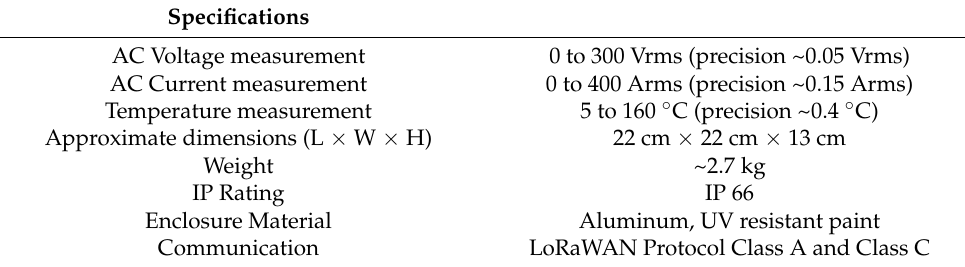
Table 1. Specifications of